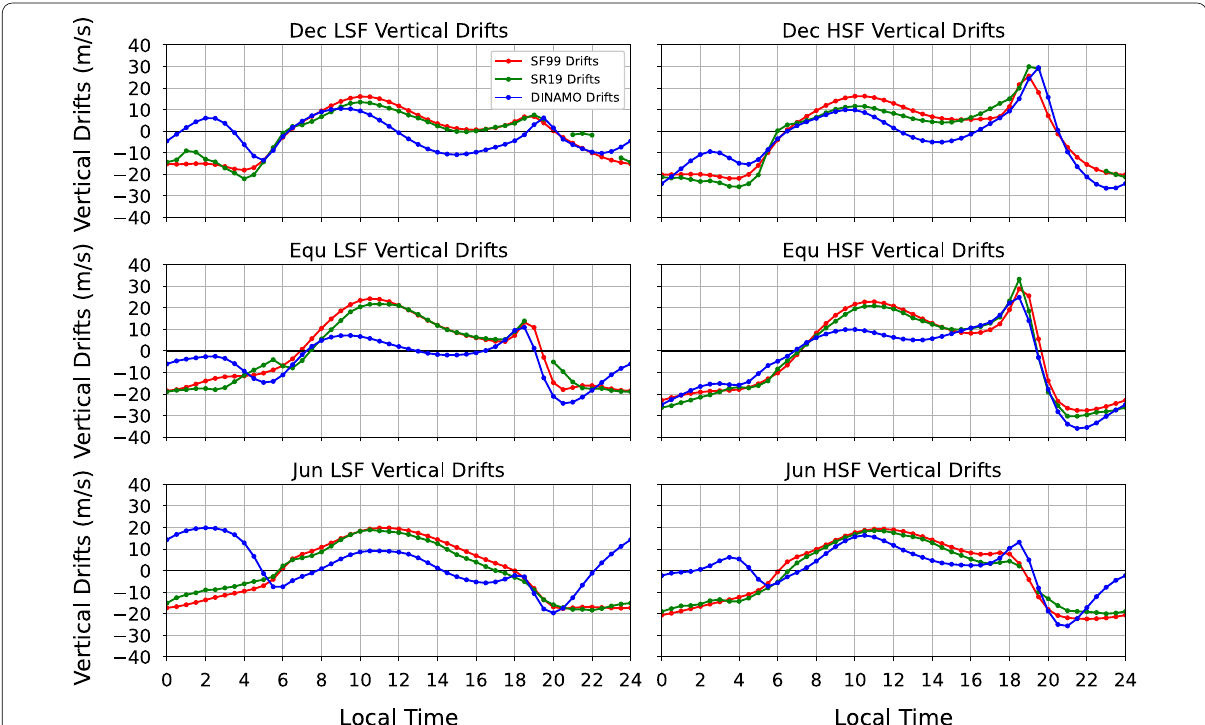
Fig. 3 Behavior of the vertical plasma drifts as a function of local time for different seasons (rows) and solar flux conditions (columns). The blue curves represent results from the DINAMO model at 360 km. The green curves represent the Jicamarca ISR observations presented by Shidler et al. (2019) for altitudes of 360 40 km. The red curves correspond to vertical drifts predicted by the SF99 model ±